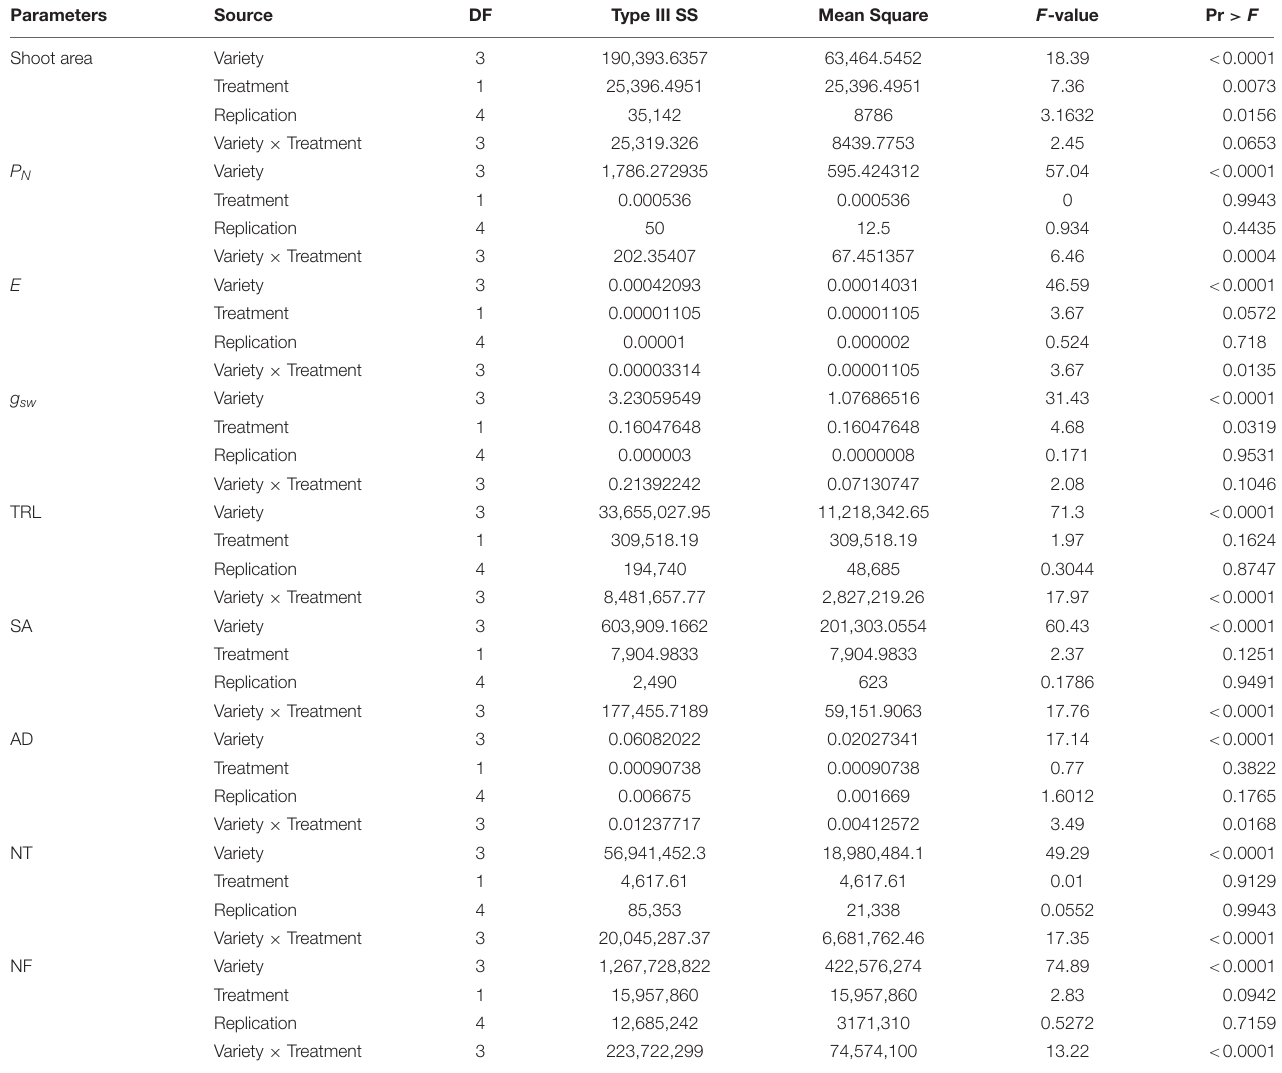
TABLE 2 | Analysis of variance (ANOVA) of the various shoot and root traits among soybean cultivars for two treatments. Parameters Source DF Type III SS Mean Square F